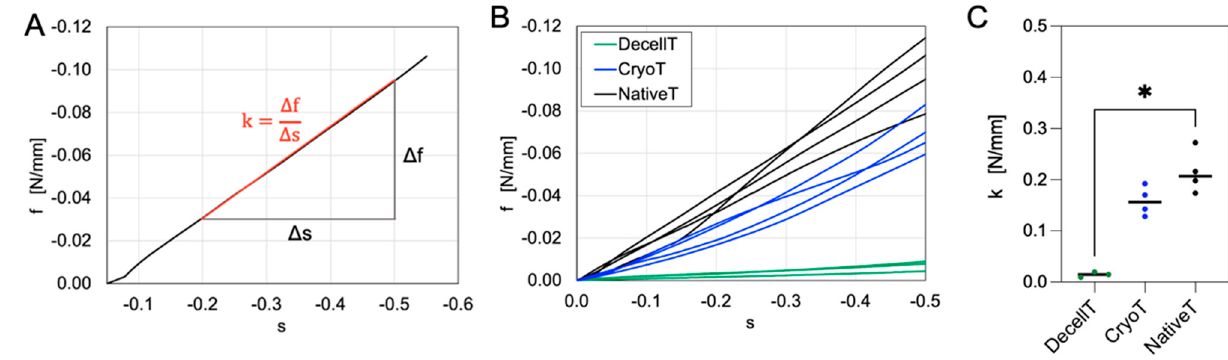
Figure 11. Results of compression tests: ( A ) Typical compression curve in terms of force per unit of length of the sample f vs. tracheal compressive deformation s in the proximal-distal direction. The compressive modulus k is the slope of the secant line between 20% and 50% of compressive deformation. ( B ) Compression curves of all the testes samples of DecellT, CryoT and NativeT. ( C ) Comparison of stiffness among all the testes samples of DecellT, CryoT and NativeT (*: p < 0.05).